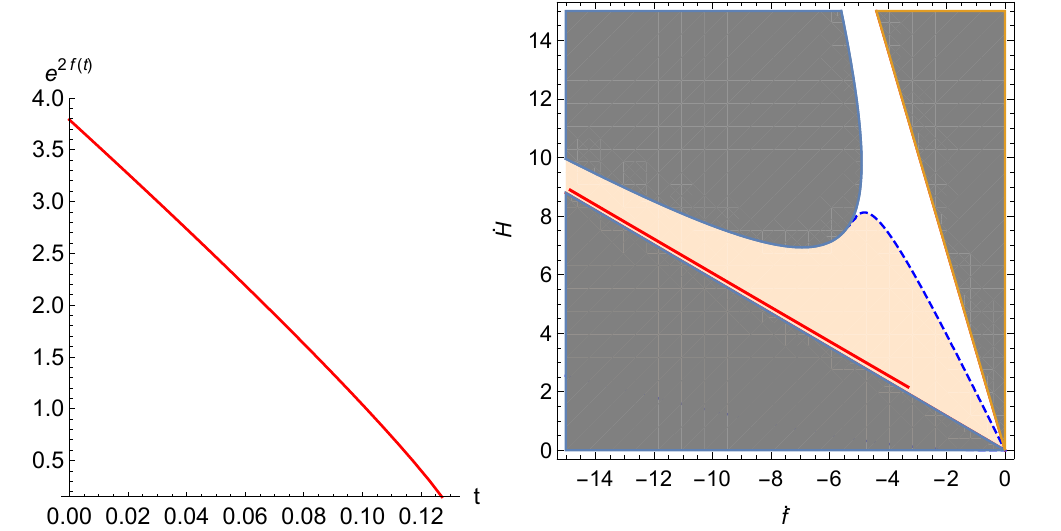
Figure 6 . A scale factor e 2 f ( t ) (left) and corresponding solution trajectory (right) in the linear approximation: the initial conditions are chosen as _ H (0) = 2, (cid:14) _ f (0) = 1 and (cid:14) _ H (0) = 1 : 6 with (cid:21) = 10 (cid:0) 1 for visualization. The light orange region stands for (cid:127) a > 0 and thus the dashed blue line can be regarded as a set of starting initial points for